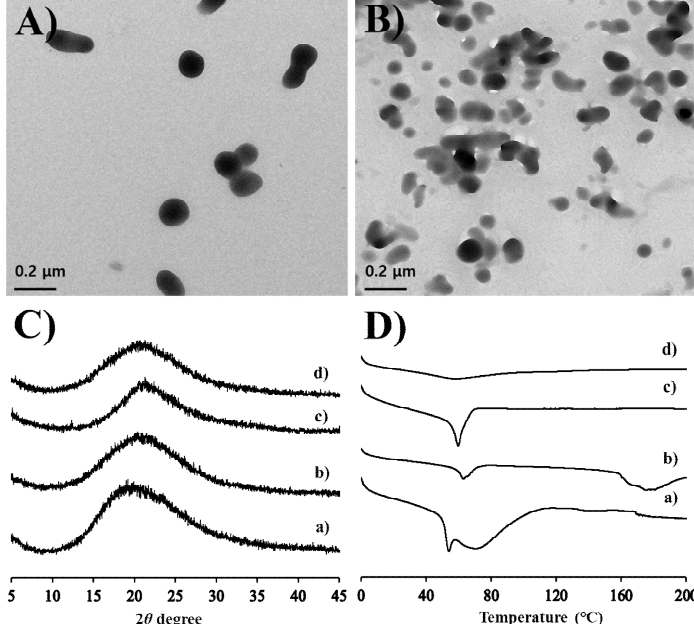
Figure 2. Morphological and physical characteristics of the MTK nanocrystal suspension and the hydrogel. SEM (scanning electron microscope) images of the MTK nanocrystals ( A ) suspended in aqueous suspension or ( B ) embedded in the hydrogel. ( C ) XRD (X-ray diffraction) patterns and ( D ) DSC (differential scanning calorimeter) curves of (a) MTK-Na powder, (b) MTK free-acid powder, (c) MTK nanocrystal suspension, and (d) MTK nanocrystal hydrogel. Table 2. Physicochemical characteristics of the optimized MTK nanocrystal suspension. Parameters